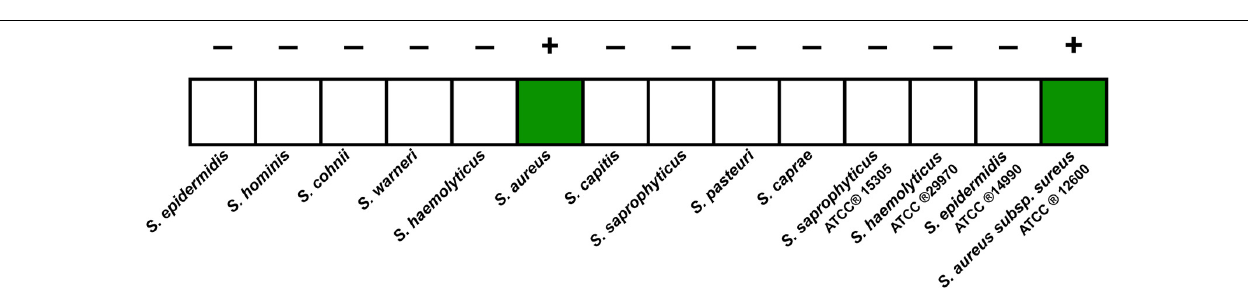
Repeats Assay We compared the LoD of the LAMP assay relative to the qRT- PCR assay for the detection of S. aureus and MRSA. A standard scatter plot was plotted using seven serial dilutions with